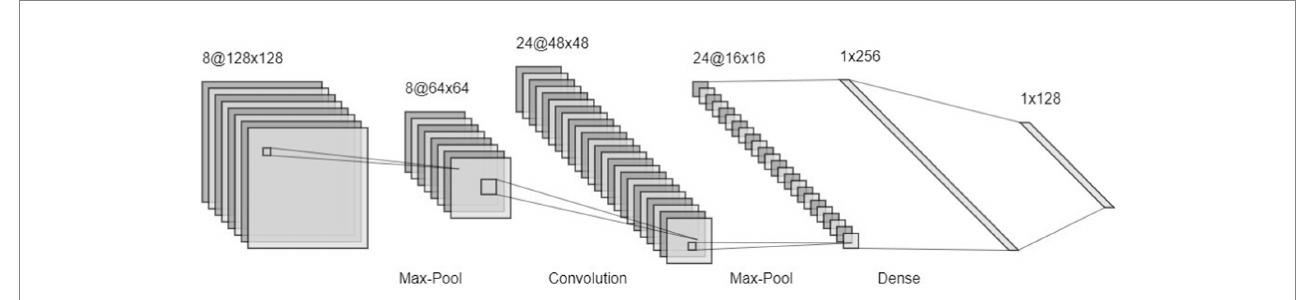
FIGURE 2 Example of a CNN architecture. The model takes an image as input; the image passes through layers to finally be classified between predefined